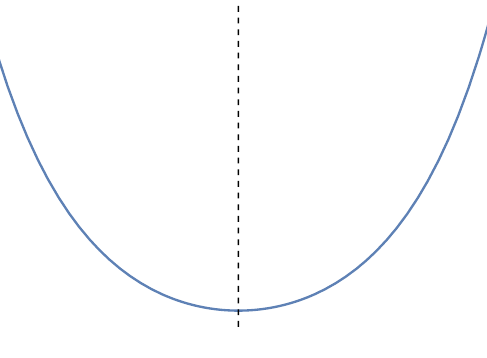
Figure 1 . A good starting point.